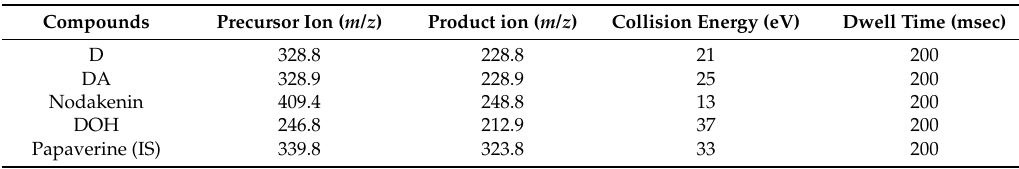
Table 4. Optimized MRM parameters for the four